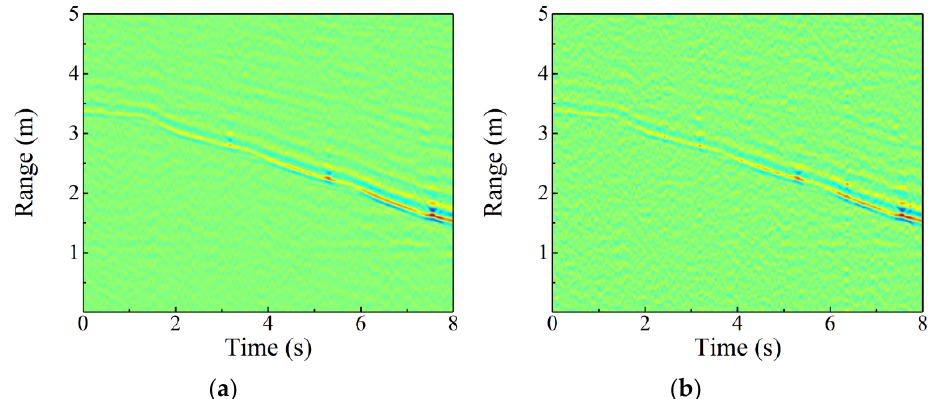
Figure 11. TR diagrams of walking forward ( a ) without and ( b ) with the white noise interference when ISR = 27.6 dB.